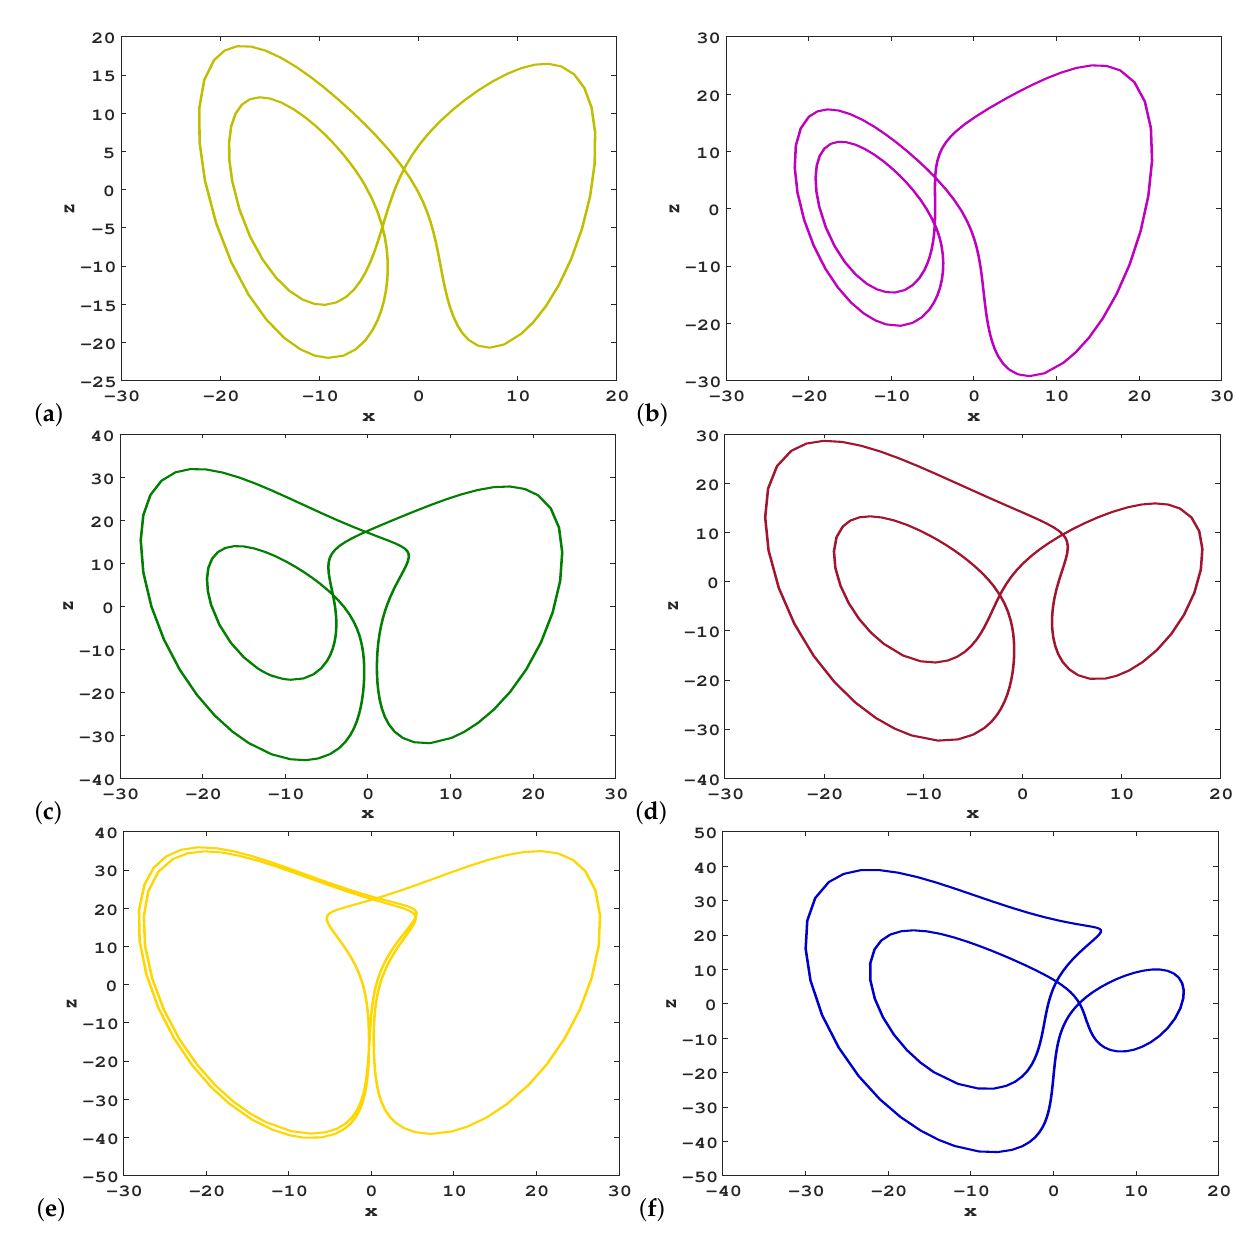
Figure 16. Unstable cycles with topological length 3 in system (2) for parameters ( a , b , c , k , m ) = ( 10,100,2.7, − 0.2,1 ) ; ( a ) cycle 001; ( b ) 003; ( c ) 023; ( d ) 021; ( e ) 223; ( f )